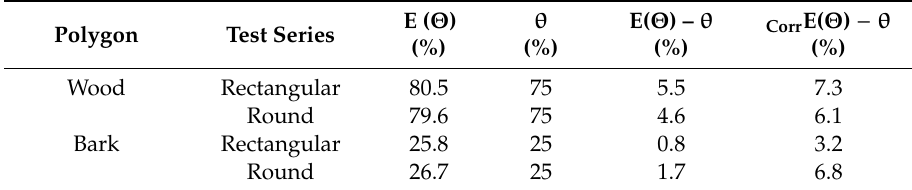
Table 4. Descriptive statistics of the calculated average debarking percentages compared to the true simulated debarking percentages of the laboratory surveys (sample size =